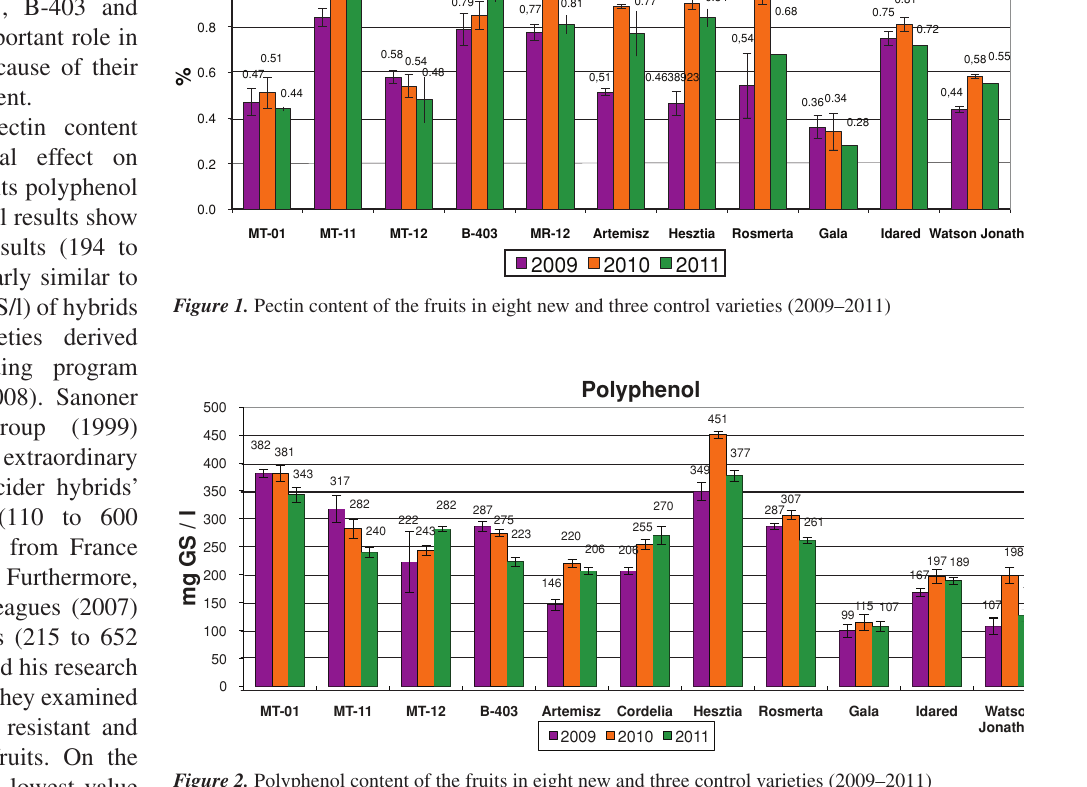
Figure 2. Polyphenol content of the fruits in eight new and three control varieties (2009–2011)